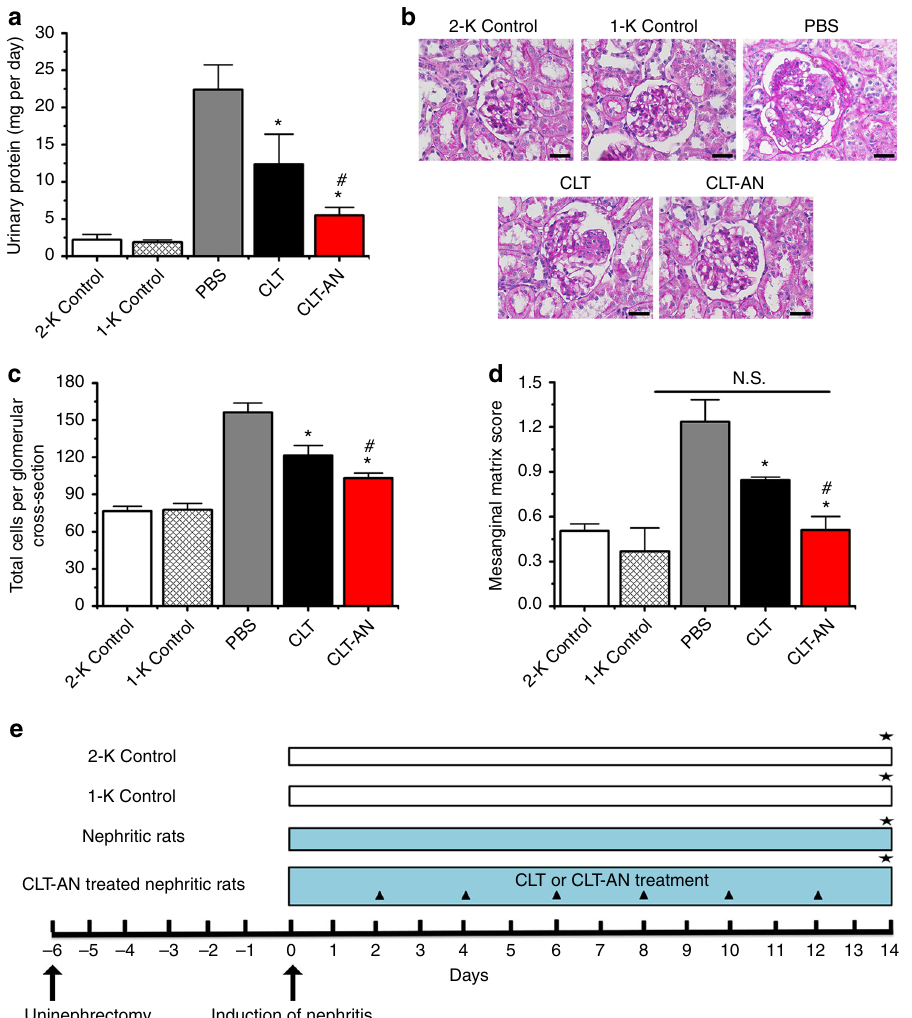
Fig. 5 Enhanced ef fi cacy of delayed CLT-AN treatment in the irreversible model. a Effects of delayed CLT or CLT-AN treatment on 24-h urinary protein excretion in anti-Thy1.1 nephritic rats on day 14 after disease induction. b Glomerular histology revealed by PAS staining of kidney tissue sections from anti- Thy1.1 nephritic rats on day 14 after delayed treatment with CLT or CLT-AN. Scale bars , 20 μ m. c Effects of delayed CLT or CLT-AN treatment on total glomerular cellularity on day 14 after disease induction. For each animal group, 150 glomeruli were selected and total glomerular cells were counted using cellSens Standard digital imaging software (Olympus). d Effects of delayed CLT or CLT-AN treatment on ECM accumulation on day 14 after disease induction. For each animal group, 150 glomeruli were analyzed and ECM deposition was graded semiquantitatively as described in Methods. In panels a , c , and d data are mean ± s.d. ( n = 5), results are representative of two independent experiments. Nonnephrectomized two-kidney control (2-K Control) and uninephrectomized one-kidney control (1-K Control) served as controls. * P < 0.05 vs. PBS group; # P < 0.05 vs. CLT group. Statistical signi fi cance was determined by one-way ANOVA with Tukey post hoc test. e Flow diagram of the treatment of CLT or CLT-AN treatment against the irreversible anti-Thy1.1 nephritis. Black triangle denotes intravenous treatment of CLT or CLT-AN; black star denotes time points of nephrectomy while respective animals were sacri fi ced. A detailed description is given in